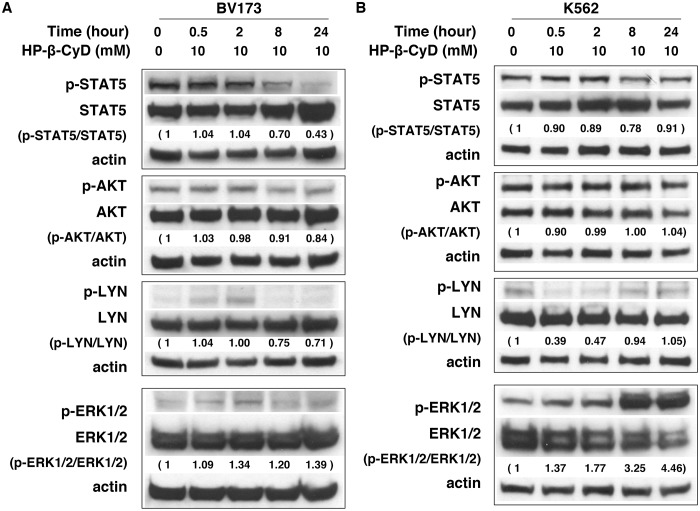
Protein expression and phosphorylation of BCR-ABL-associated kinases in leukemic cell lines treated with HP-β-CyD.BV173 and K562 cells were treated with 10 mM HP-β-CyD for the indicated times, after which STAT5, AKT, LYN, and ERK1/2 protein levels, and the phosphorylation status of each protein were determined by western blot analysis. Detection of β-actin was used as a loading control. Data are representative of three independent experiments. Intensity of the immunoblot signals after background subtraction was quantified using ImageJ software, and the relative intensities of p-STAT5, p-AKT, p-LYN, and p-ERK1/2 compared to those of STAT5, AKT, LYN, and ERK1/2 were respectively calculated.